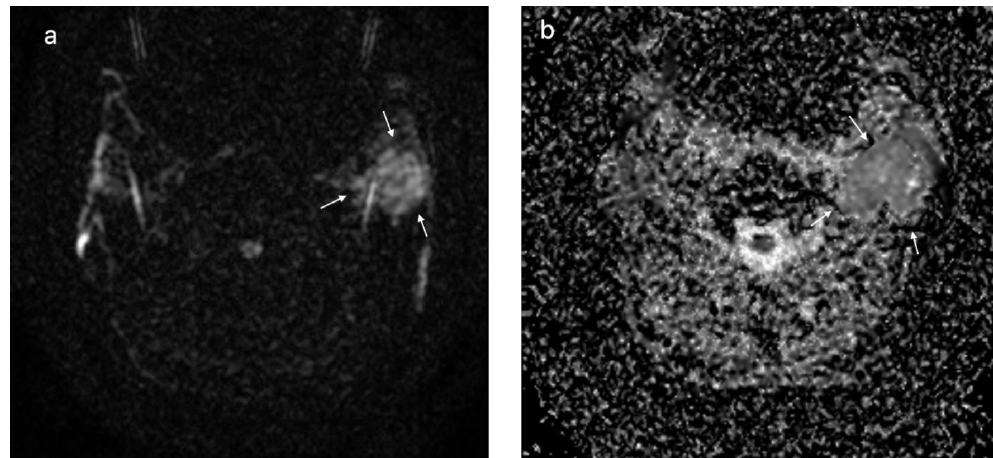
Figure 6. Pleomorphic adenoma located at the level of the left parotid gland (white arrows); DWI sequences ( a ) with ADC map ( b ) showing a value of 1.6 × 10 − 3 mm 2 /s.